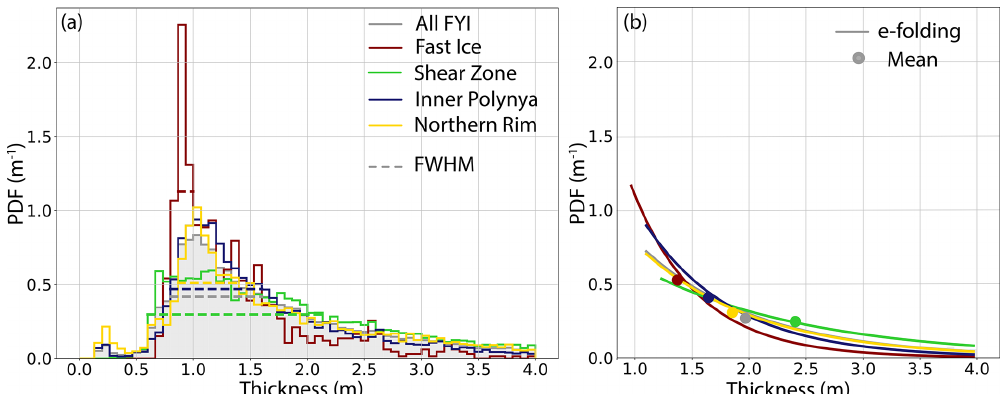
Figure 5. ITDs of the four FYI zones of all three AEM lines on 30/31 March 2018. The ITDs differ in (a) FWHM that characterizes the dominance of the mode and (b) mean and e folding of the exponential tail. The ITD of the complete measurements (all FYI) is displayed in